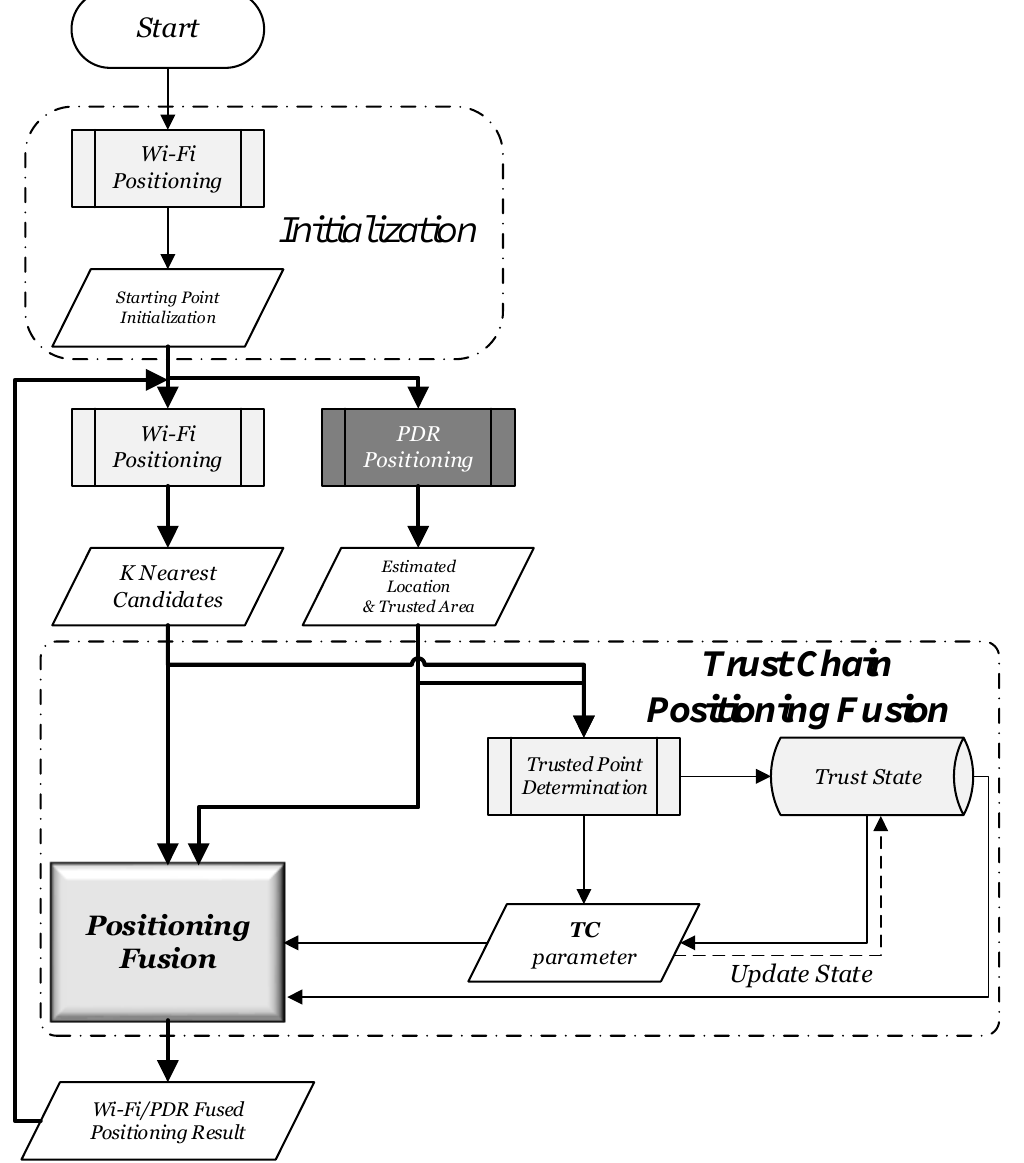
Figure 6. Algorithm flow of proposed fusing positioning.